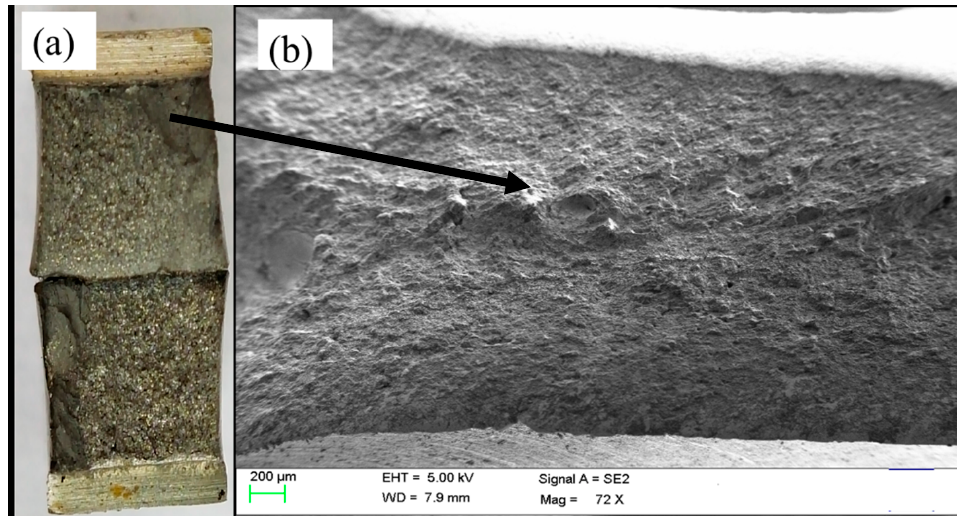
Figure 9. Fracture surface image of Charpy V-notch impact test results at − 80 °C. ( a ) Fractured surface and ( b ) SEM image.